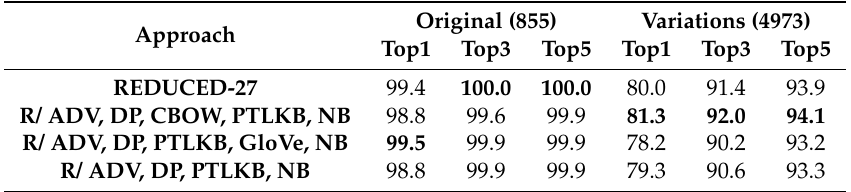
Table 9. Proportion of original questions and variations correctly matched with original FAQs (Top1), in Top-3 and in Top-5 most similar, using the most promising reduced STS models.